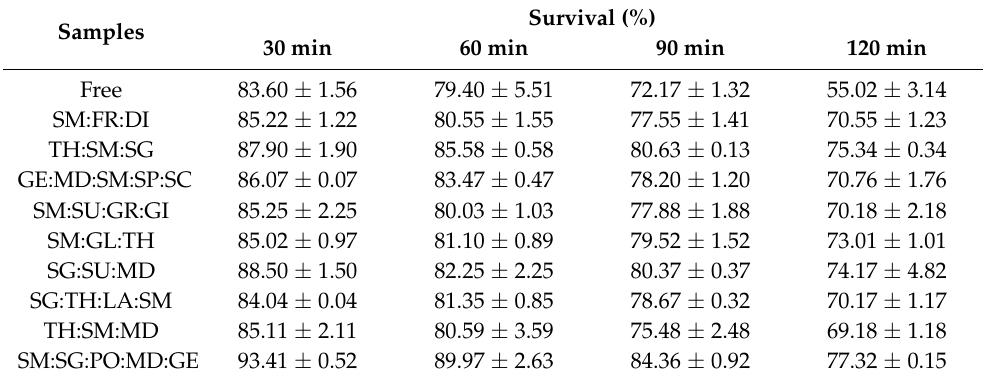
Table 6. Tolerance of microencapsulated LR-LFCA to simulated intestinal juice.